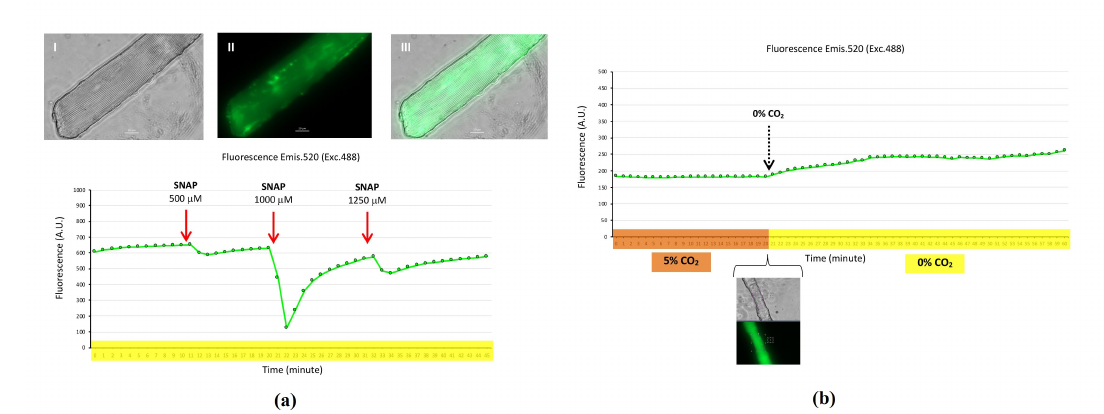
Figure 7. Biosensor G-geNOp for monitoring cytosolic nitric oxide in isolated skeletal muscle fibers. ( a ) A fiber that expressed G-geNOp: Transmitted light ( I ), fluorescence ( II ), and combined transmitted light and fluorescence ( III ). Graphic presents the registration of fluorescence emission at 520 nm (excitation 488 nM) in arbitrary units (A.U.) of that fiber that expressed G-geNOp during a 45 min time course where the fibers were maintained at 37 ◦ C in a 0% CO 2 atmosphere (timeline highlighted in yellow). The nitric oxide donor SNAP was added at different timepoints, with final concentrations of 500 µ M (10 min), 1000 µ M (20 min), and 1250 µ M (31 min). ( b ) Monitoring fluorescence emission at 520 nm (excitation 488 nM) in arbitrary units (A.U.) from a fiber that expressed G-geNOp during a 60 min time course, with fluorescence registration every min. The first 20 min fiber was maintained at 37 ◦ C in a 5% CO 2 atmosphere (timeline highlighted in orange) and switched to 37 ◦ C in a 5% CO 2 atmosphere for the following 40 min of the time course (timeline highlighted in yellow). Fiber images: Transmitted and fluorescence, at the 20 min timepoint, where the area of the fiber selected for fluorescence quantification is shown. (Supplementary enlarged